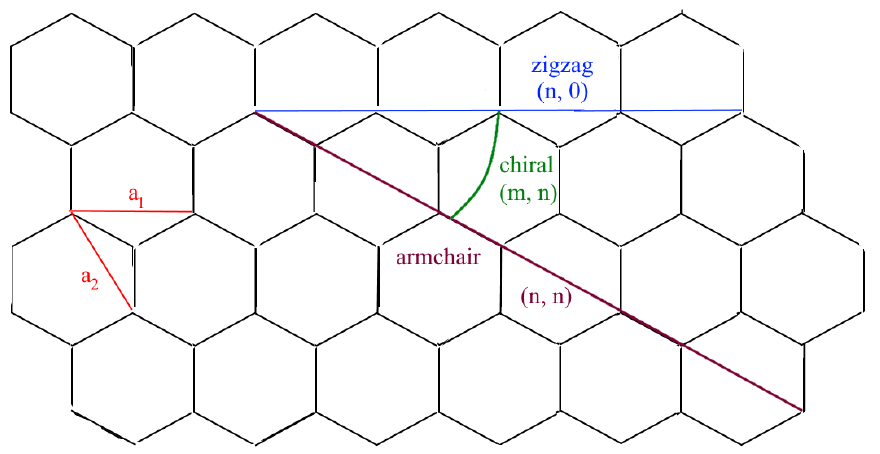
Figure 2. Illustration of the typical basis (vectors a 1 and a 2 ) and the chiral vectors of zigzag, armchair, and general chiral single-walled nanotubes on a sheet of graphene.